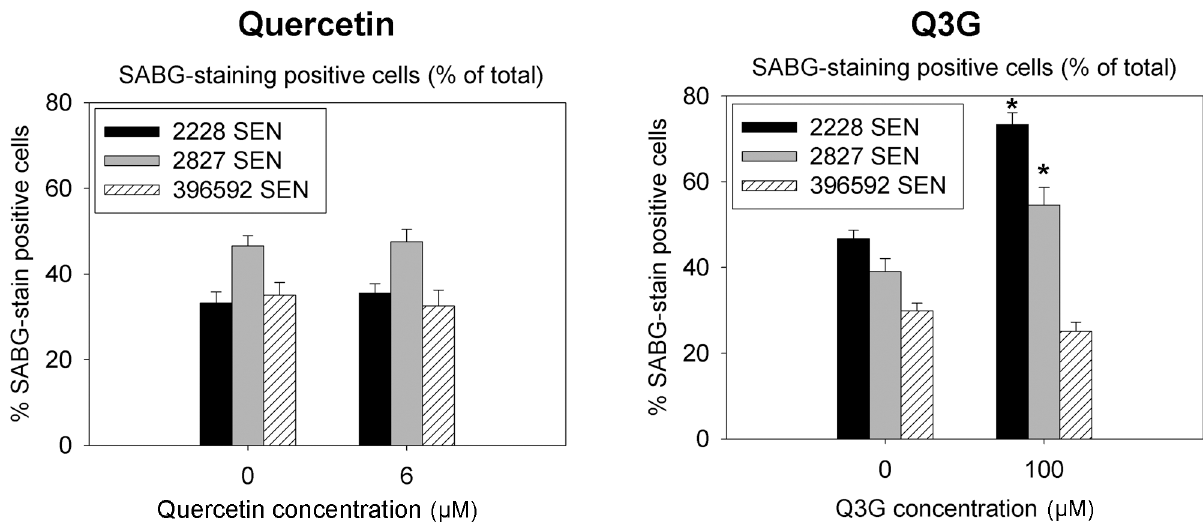
Fig 4. Manual quantification of SABG stain-positive cells. SEN cells from the same three donors were treated with 6 μ M quercetinand 100 μ M Q3G followedby SABG staining.Manualcounting was done to assess percent of SABG positive cells. * p < 0.05vs. baselinevalue (N = 12 wells/group, per donor, where each N rangedfrom 40 to 160 cells). T-test was used to determinestatistical significancebetween control and test groupsfor each